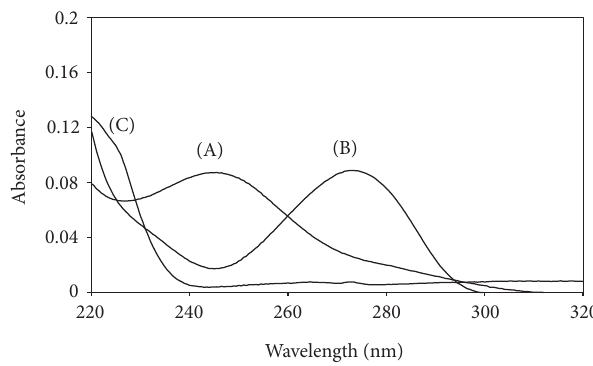
F 1: Absorption spectra of aspirin, 50